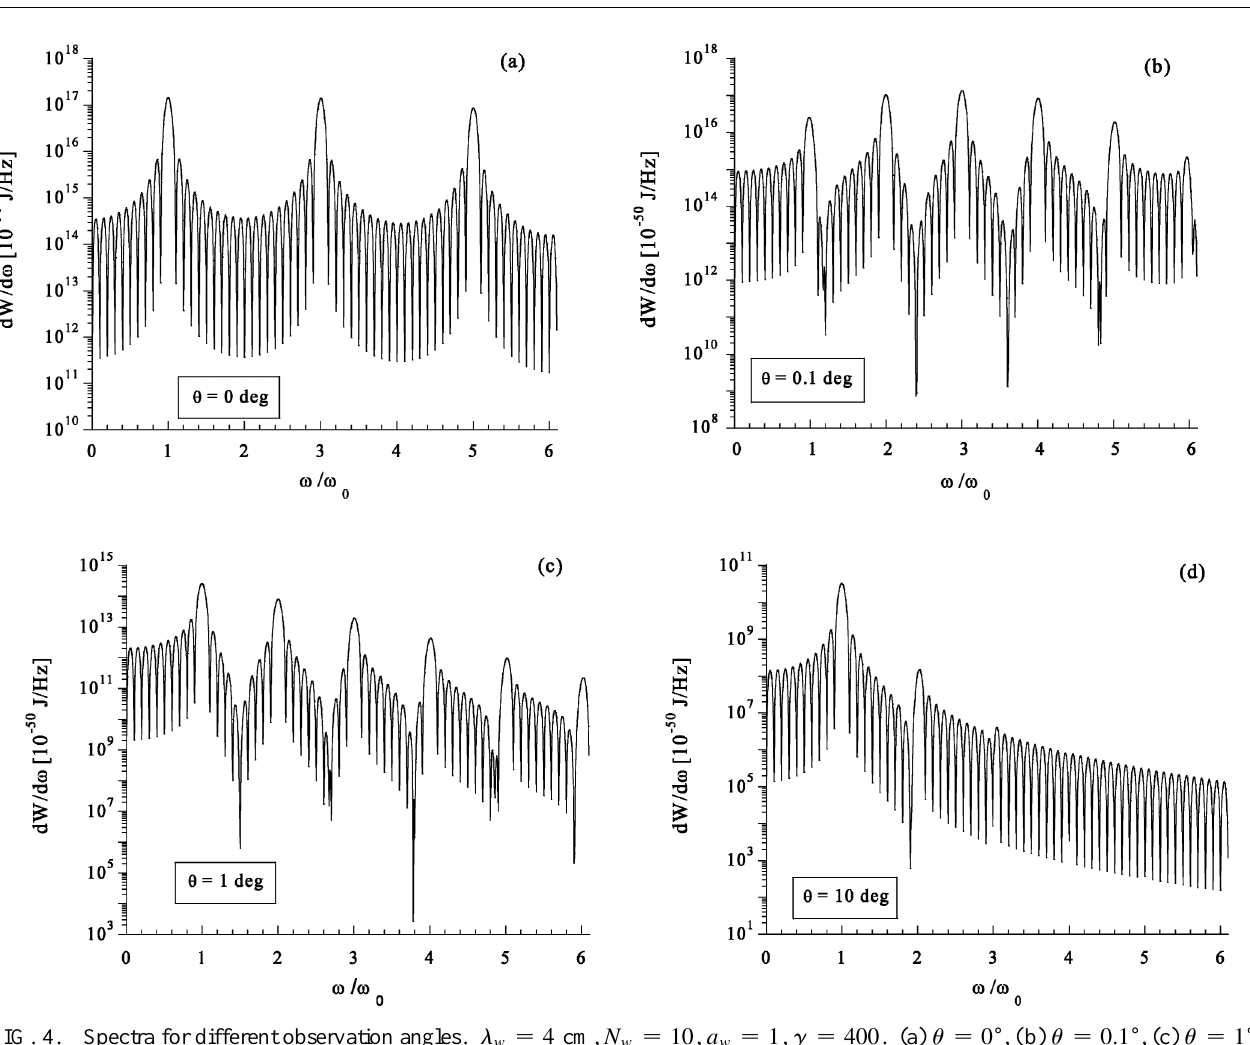
FIG. 4. Spectra for different observation angles. l w (cid:1) 4 cm, N w (cid:1) 10 , a w (cid:1) 1 , g (cid:1) 400 . (a) u (cid:1) 0 ± , (b) u (cid:1) 0.1 ± , (c) u (cid:1) 1 ± , and (d) u (cid:1) 10 ± .